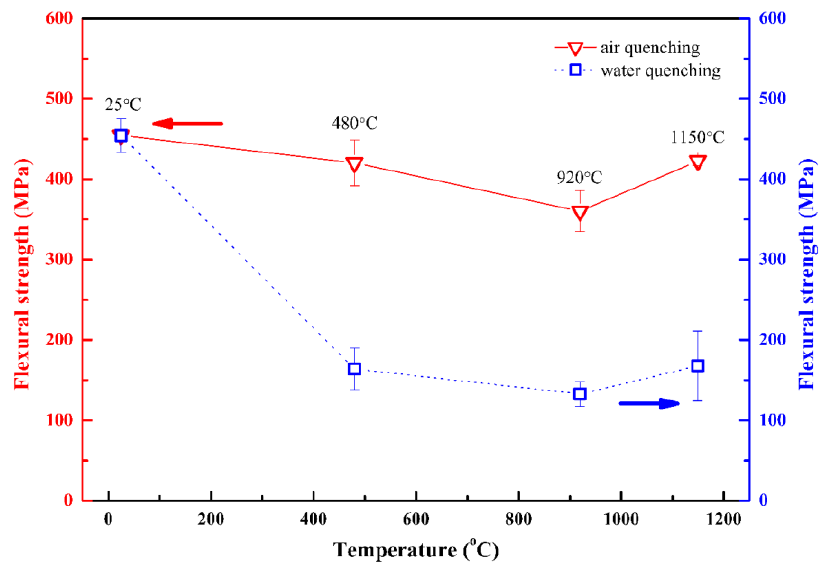
Figure 9. Residual flexural strength of air-quenched and water-quenched Ti 2 AlC samples rapidly heated in air.